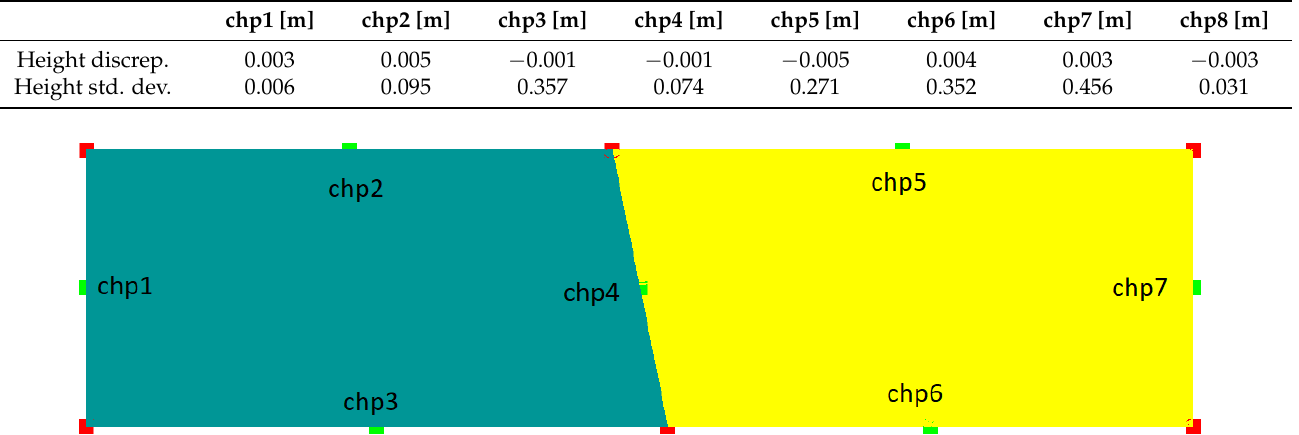
Table 3. Height discrepancies of check points and the standard deviations of the height of the surrounding check point.